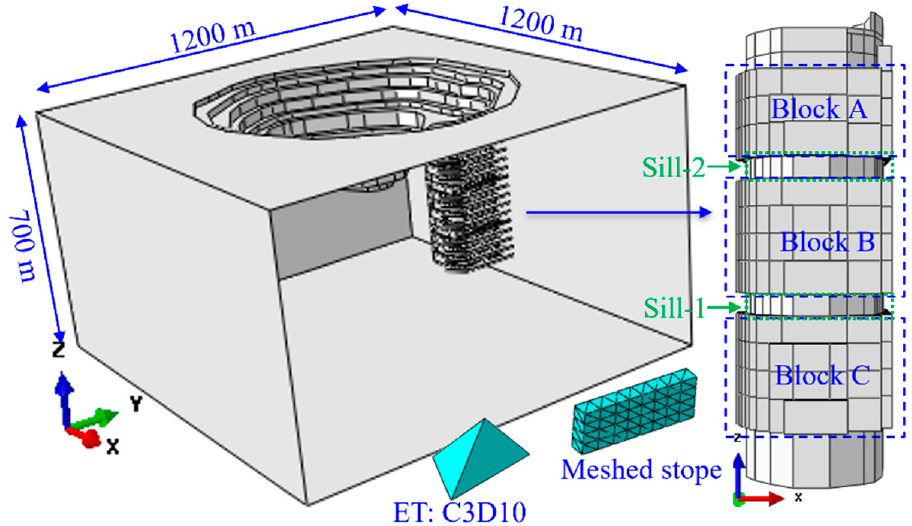
Figure 1. Two sill pillars in pipe MP#1.